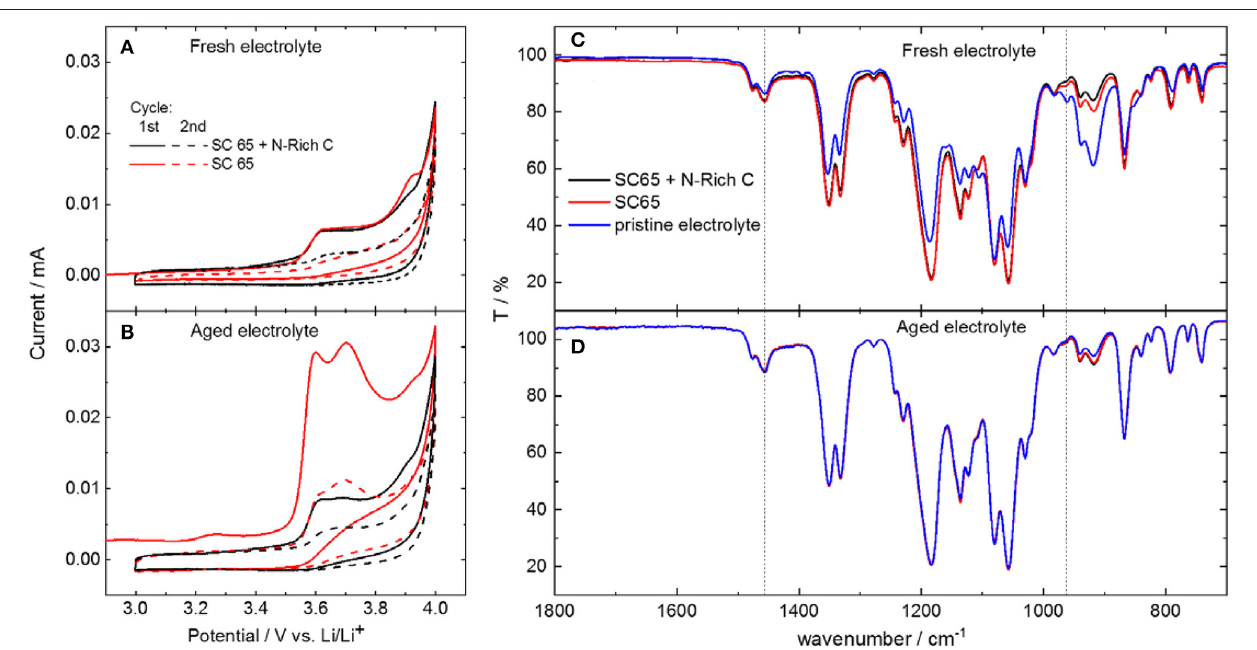
FIGURE 4 | Electrochemical stability window determined by cyclic voltammograms with different carbon-based electrodes, of (A) fresh and (B) aged electrolytes. IR spectra of (C) fresh and (D) aged electrolyte extracted from the cell. The spectra of the uncycled electrolyte is also shown for